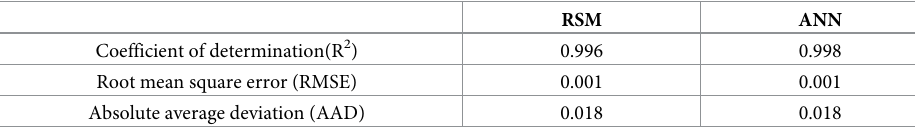
Table 9. Comparison of predictive capacity of RSM and ANN